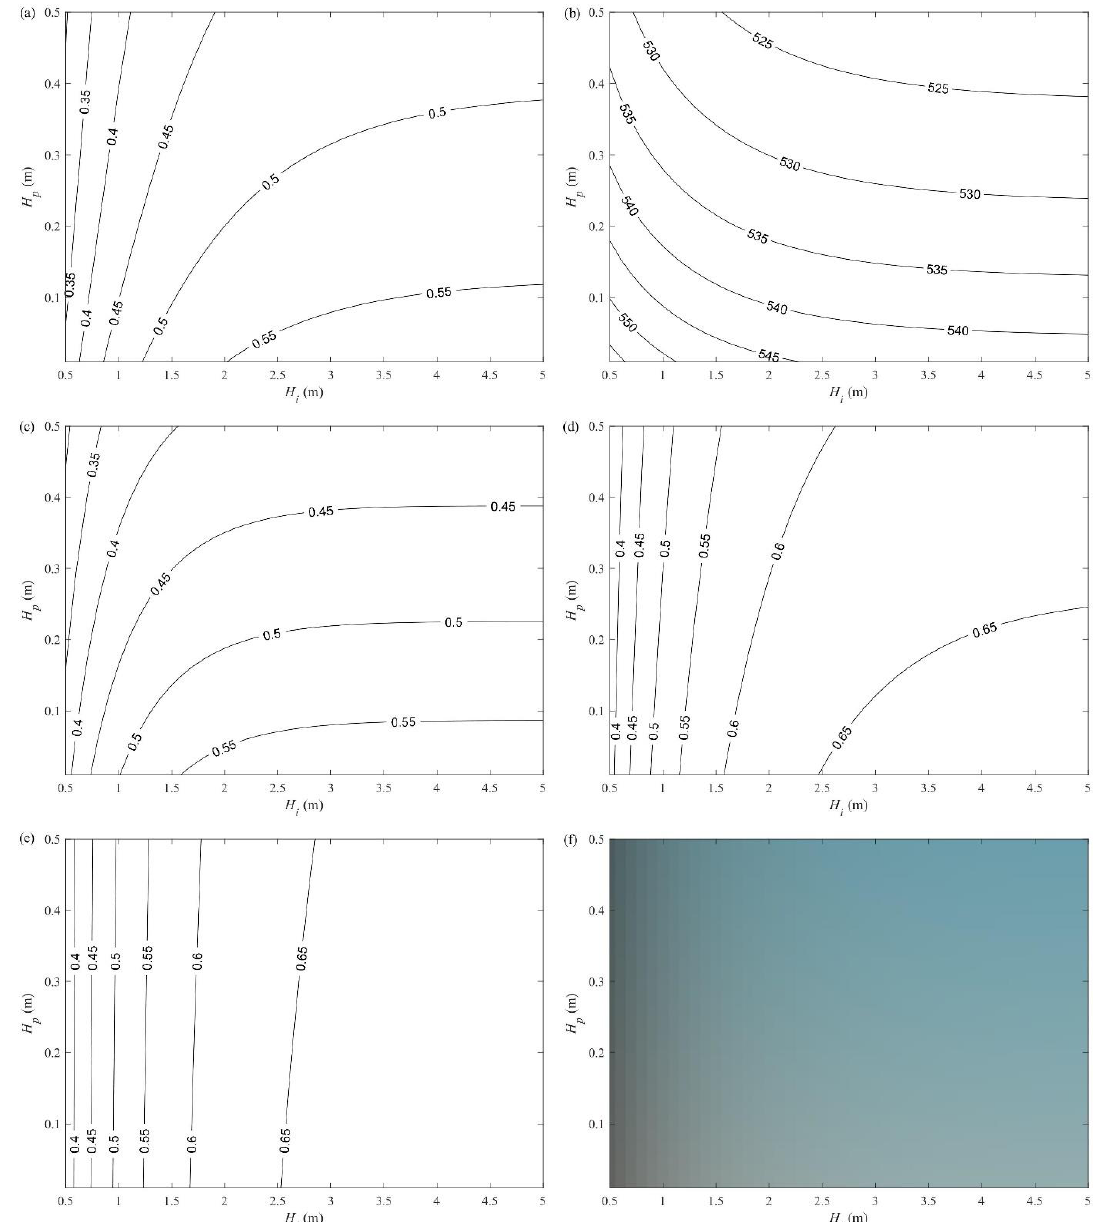
Figure 4. Variations of melt-pond optics and color with pond depth and underlying ice thickness: (a) integrated pond albedo α B , (b) mean wavelength determined by Eq. (1), (c–e) intensities of red, green and blue components scaled in the range of 0–1, (f) simulated color of the melt pond in the RBG color space according to the colorimetric method defined by Eqs. (2)–(6). The sky condition is